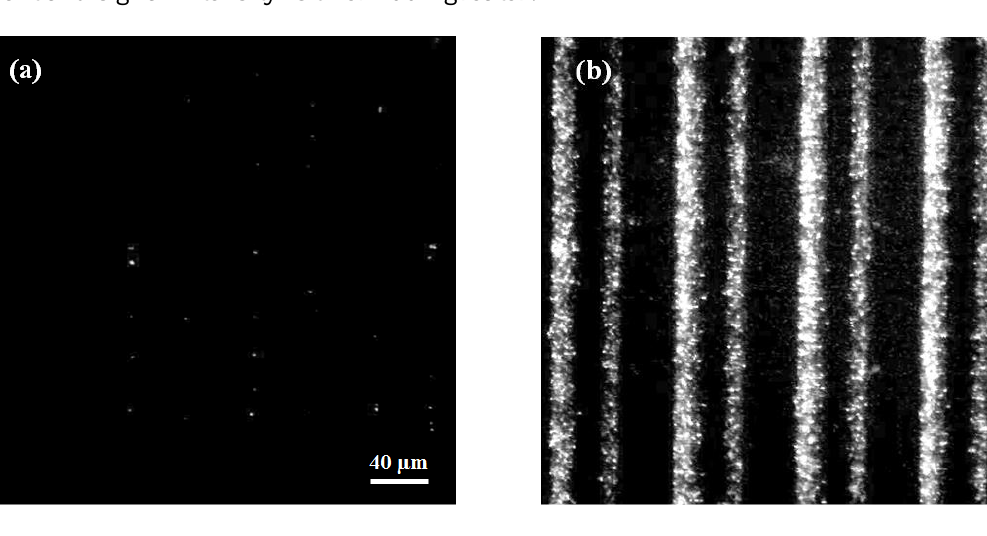
Figure 3. Dielectrophoretic capture and concentration of bacterial cells. Both images have identical camera gain and contrast settings and identical scale/magnification. ( a ) Prior to dielectrophoretic capture and concentration, SYTO ® -9 stained bacteria (10 6 cfu/mL) are barely detectable. ( b ) After one minute of capture at 1 MHz and 100 µL/min, bacteria are evident and signal intensity is over 400×